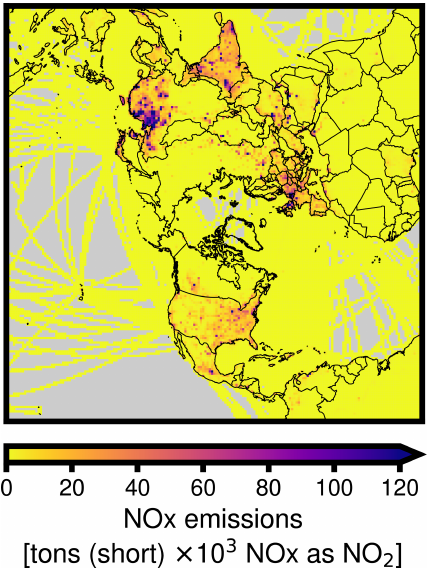
Figure 5. 2019 prior anthropogenic NO x emissions totals. Data sources are described in Table